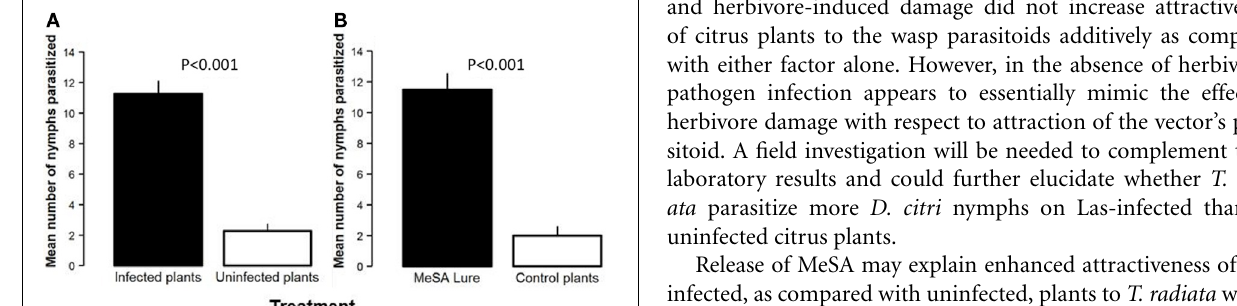
different (2.50 ± 0.29 and 2.75 ± 0.48, respectively). Similarly,